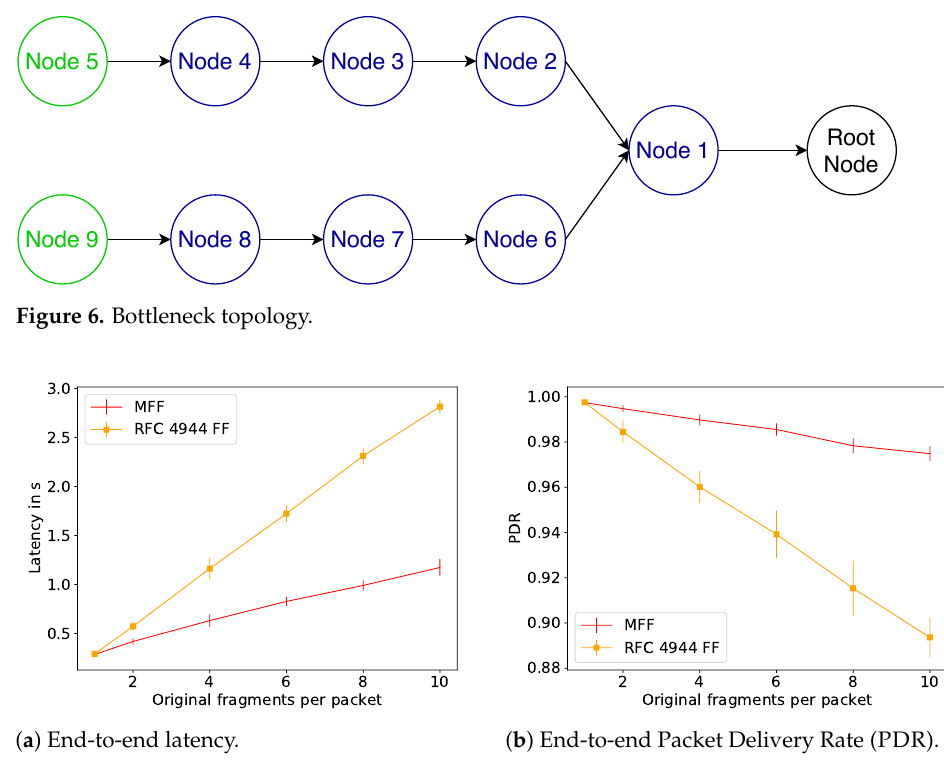
Figure 7. Performance evaluation of the schemes proposed by the